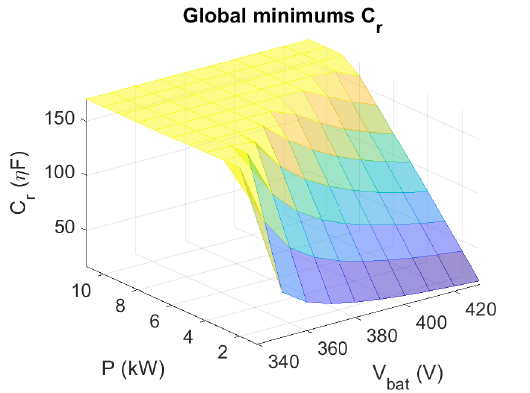
Figure 14. Global minimums of C r with respect to battery voltage and power